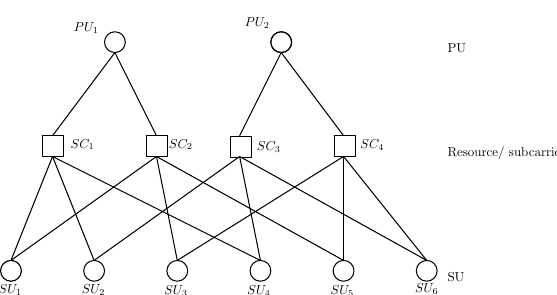
Figure 3. The relationship of PUs, SUs, and resources in a